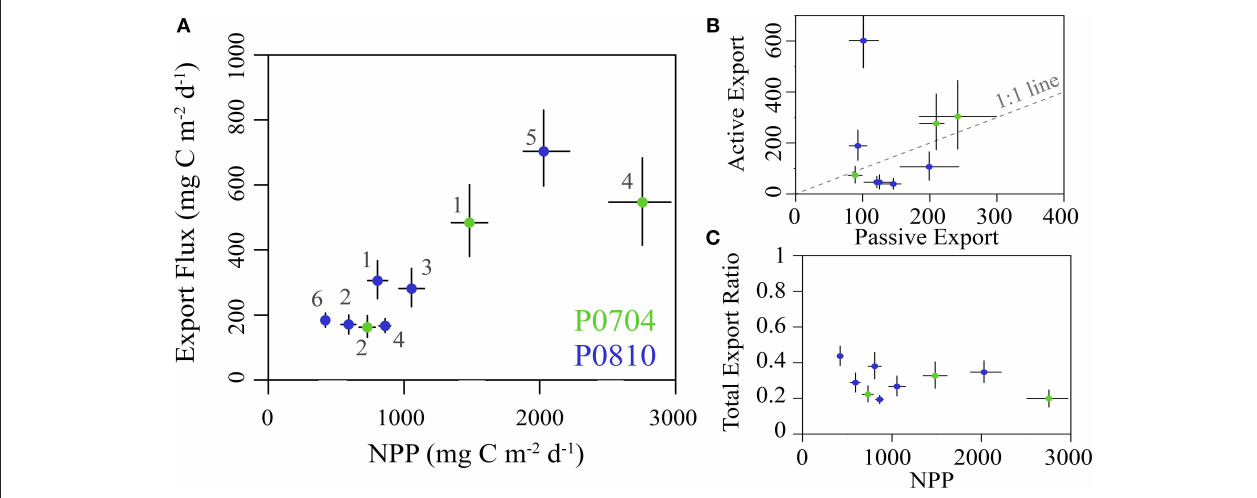
FIGURE 6 | (A) The sum of both passive and active carbon export flux from the epipelagic plotted against NPP. Cruises are color coded and error bars show the 95% CI for each value. (B) The total active flux due to DVM verses passive flux for each cycle (as in A ). Dashed 1:1 line for reference. (C) The total export ratio (i.e., total epipelagic export/NPP) plotted against NPP and colored as in (A) . All values are in mg C m − 2 d − 1 .